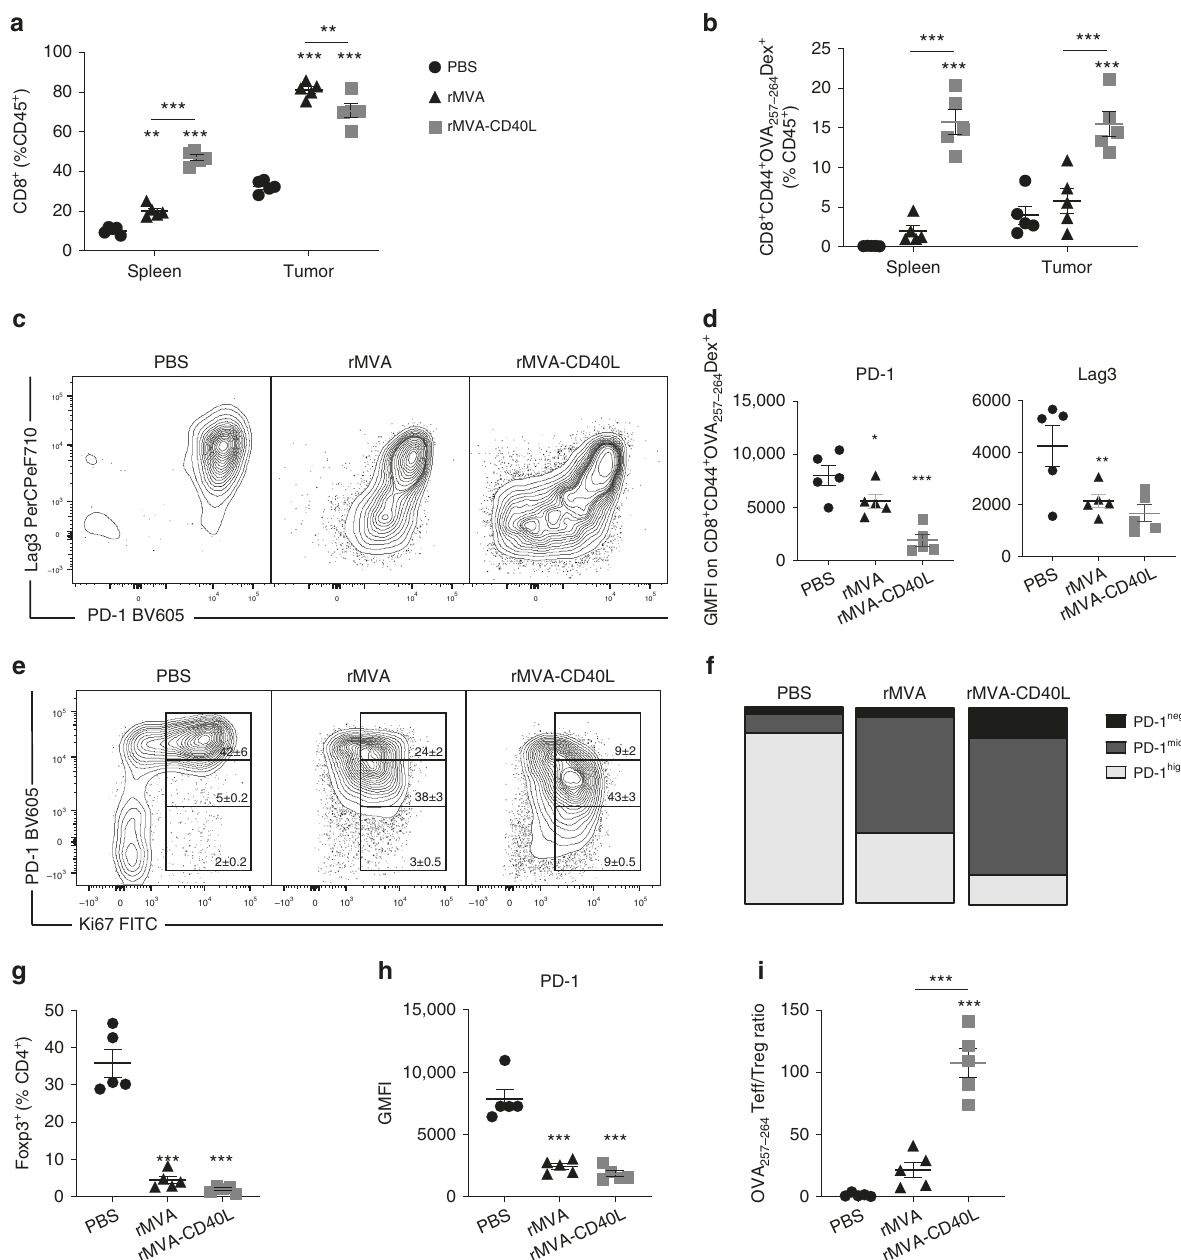
Fig. 2 rMVA-CD40L increases intratumor T cell in fi ltration of non-exhausted CD8 + T cells. B16.OVA tumor bearers were immunized when tumors reached at least 50 mm 3 in volume. Seven days later, mice were killed for further analysis ( n = 5 mice/group). a Frequency of CD8 + T cells among leukocytes in the spleen and tumor tissues. b Distribution of OVA 257-264 -speci fi c CD8 + T cells in different organs upon immunization. c Representative dot plot of PD-1 and Lag3 co-expression in tumor-in fi ltrating OVA 257-264 -speci fi c CD8 + T cells. d GMFI of PD-1 and Lag3 on tumor-in fi ltrating OVA 257-264 - speci fi c CD8 + T cells. e Representative dot plot of Ki67 and PD-1 expression on tumor-in fi ltrating CD8 + T cells showing mean ± SEM, representative of at least two independent experiments. f Bar chart representing PD-1 expression on Ki67 + TILs shown in e . g Frequency of tumor-in fi ltrating FoxP3 + T reg among CD4 + T cells. h GMFI of PD-1 on tumor-in fi ltrating T reg . Data expressed as mean ± SEM, representative of at least two independent experiments. i OVA 257-264 -speci fi c CD8 + T cell (OVA 257-264 T eff ) to T reg ratio. Data expressed as mean ± SEM, representative of at least two independent experiments in d , f , g , h , and i . One-way ANOVA comparing treatment groups. a , b Two-way ANOVA comparing cell frequencies in analyzed organs upon treatment. Statistics were run comparing treatment vs. PBS. * p < 0.05; ** p < 0.01; *** p <